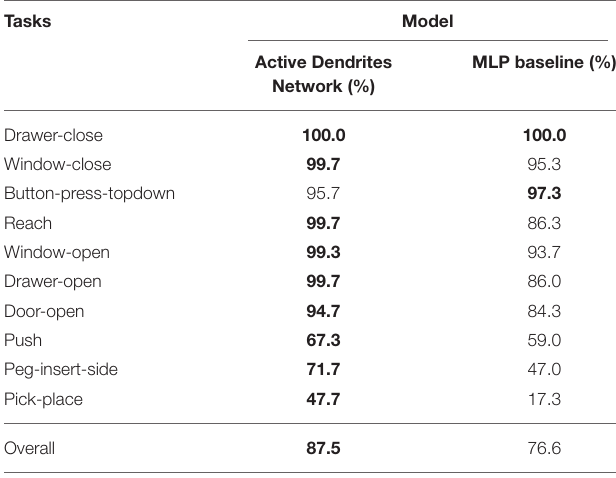
Experiment 2 : The high variance in Figure 5 (left) is inherent in many RL scenarios (Irpan, 2018; Ibarz et al., 2021). This is in large part due to the highly stochastic and dynamic training